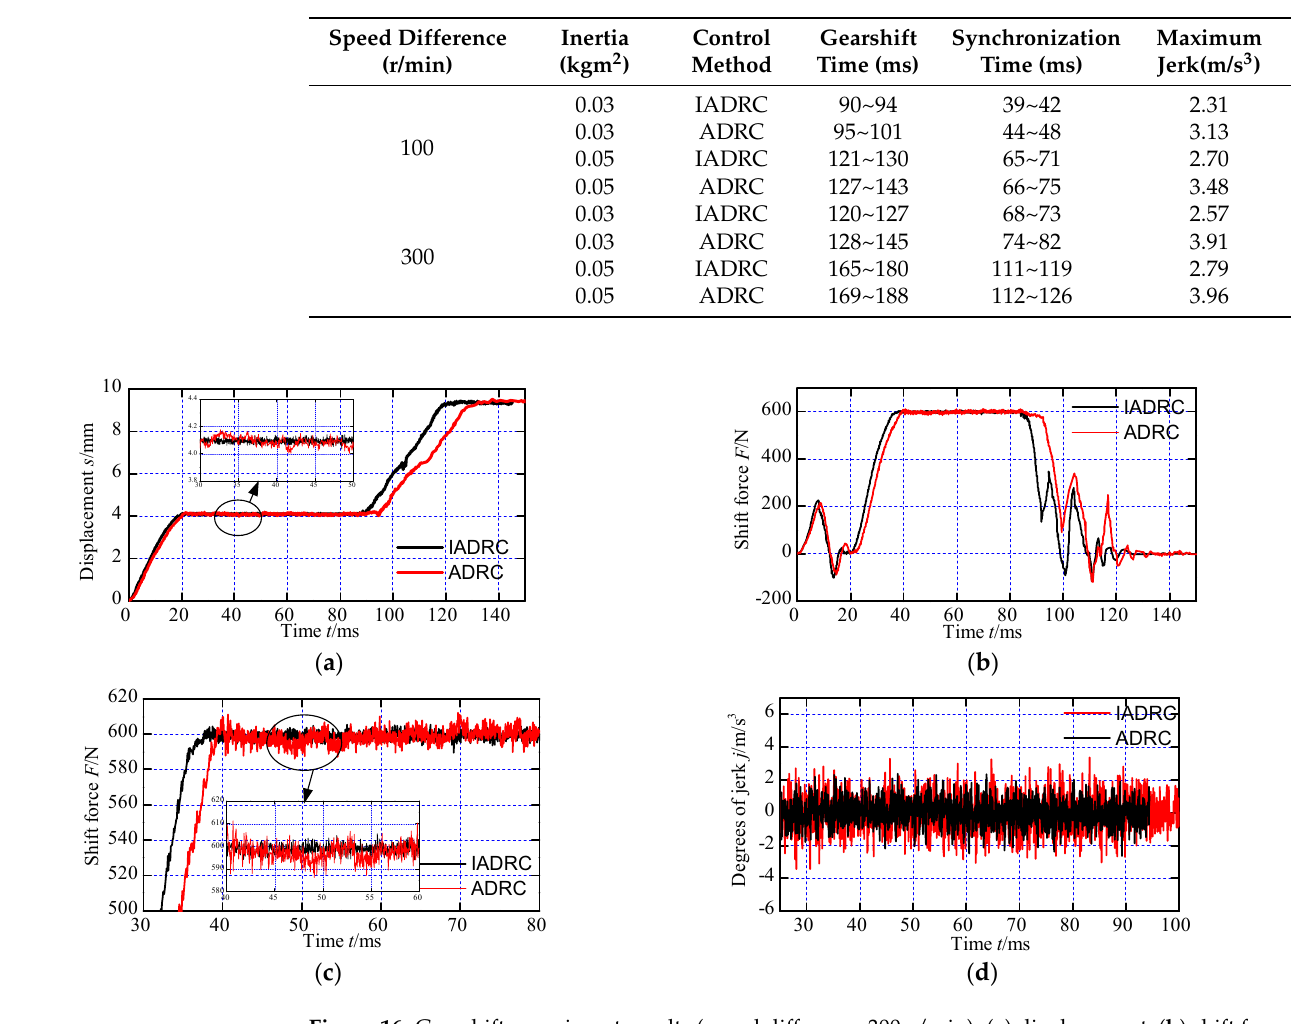
Table 1. Gearshift indexes of 30 times gearshift events.